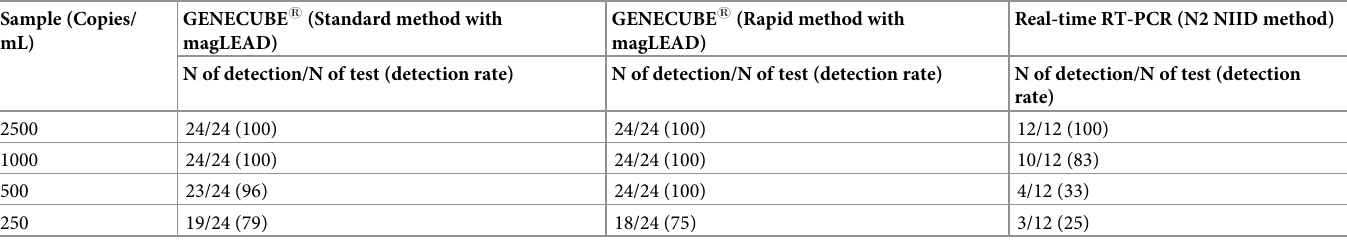
Table 3. Summary of the estimated LOD test results for three SARS-CoV-2 detection methods.